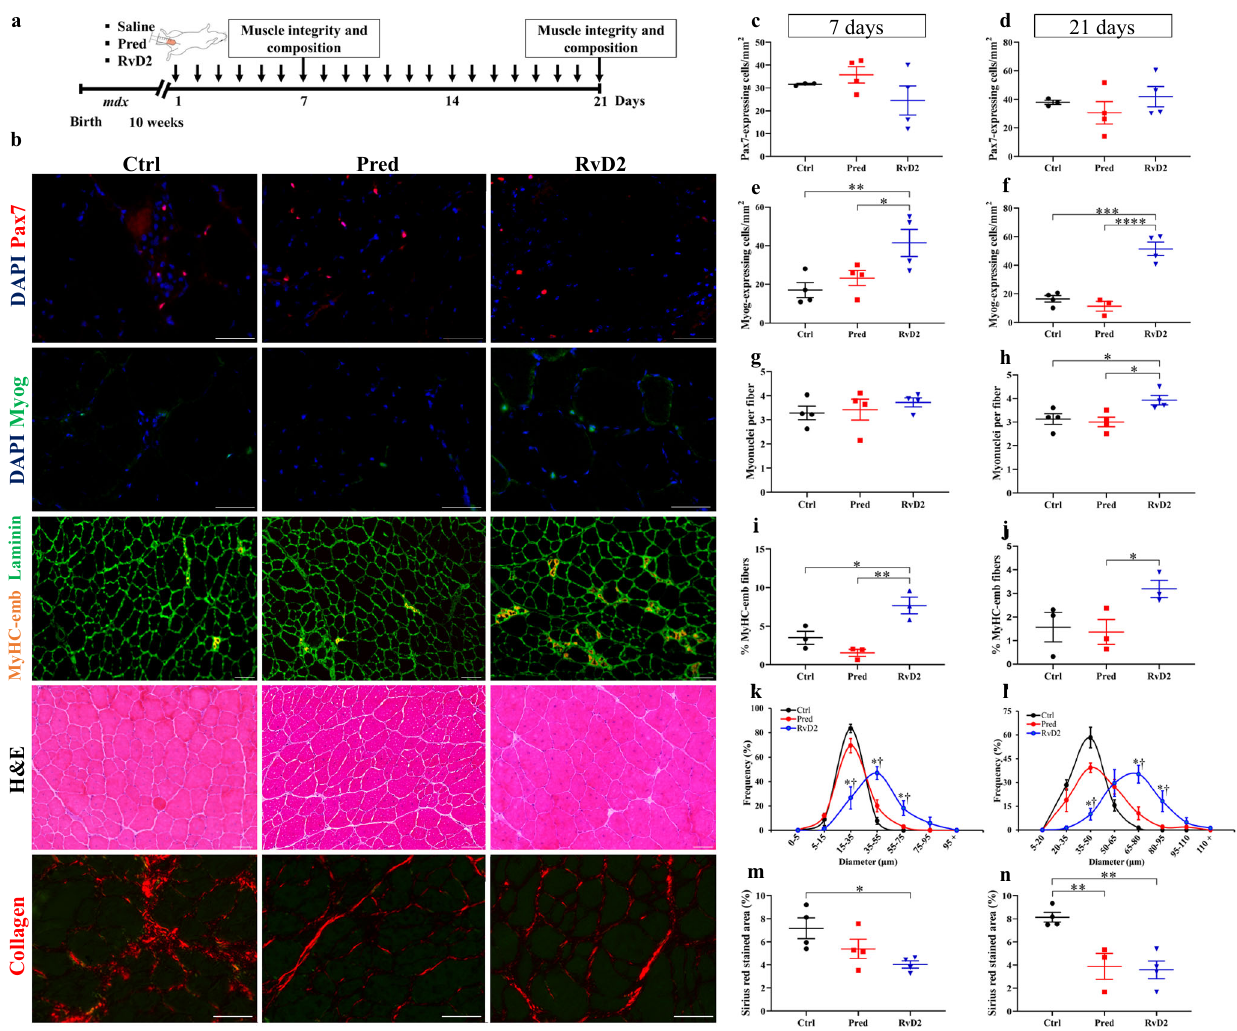
Fig. 5 Resolvin-D2 promotes myogenesis to a higher level than glucocorticoids in dystrophic mdx mice. a Timeline of daily intraperitoneal ( ip ) injection of Resolvin-D2 (RvD2, 5 ug/kg/day), prednisone (pred, 2 mg/kg/day), or vehicle (ctrl) in mdx mice. b Representative images of Pax7 (red), Myog (green), embryonic Myosin Heavy Chain (MyHC-emb; orange) + laminin (green), H&E on muscle sections of tibialis anterior (TA) muscle and collagen (Sirius red; red) on diaphragm sections of mdx mice treated with RvD2, pred, or vehicle. Scale bars = 50 μ m. c – f Quanti fi cation of number of Pax7 + ( c , d ) and Myog + cells ( e , f ) in TA muscles of mdx mice treated for 7 days ( e : Ctrl vs. Pred, p = 0.4138; Ctrl vs. RvD2, p = 0.0084; Pred vs. RvD2, p = 0.0338) or 21 days ( f : Ctrl vs. Pred, p = 0.3720; Ctrl vs. RvD2, p = 0.0001; Pred vs. RvD2, p < 0.0001). g , h Number of myonuclei per fi ber after 7 or 21 days of treatment (21 d: Ctrl vs. Pred, p = 0.6880; Ctrl vs. RvD2, p = 0.0263; Pred vs. RvD2, p = 0.0134). i , j Proportion of myo fi bers expressing embryonic Myosin heavy chain (MyHC-emb) after 7 (Ctrl vs. Pred, p = 0.1513; Ctrl vs. RvD2, p = 0.0124; Pred vs. RvD2, p = 0.0021) or 21 days of treatment (Ctrl vs. Pred, p = 0.7919; Ctrl vs. RvD2, p = 0.0681; Pred vs. RvD2, p = 0.0467). k , l Distribution curve of minimal fi ber diameter in TA muscles of mdx mice treated for 7 days (15 – 35 μ m: Ctrl or Pred vs. RvD2, p < 0.0001. 35 – 55 μ m: Ctrl vs. RvD2, p < 0.0001; Pred vs. RvD2, p = 0.0001. 55 – 75 μ m: Ctrl vs. RvD2, p = 0.0058; Pred vs. RvD2, p = 0.0181) or 21 days (35 – 50 μ m: Ctrl or Pred vs. RvD2, p < 0.0001. 65 – 80 μ m: Ctrl or Pred vs. RvD2, p < 0.0001. 80 – 95 μ m: Ctrl vs. RvD2, p = 0.0035; Pred vs. RvD2, p = 0.0101). m , n Proportion of diaphragm muscle section stained with Sirius red (collagen) after 7 days (Ctrl vs. Pred, p = 0.1176; Ctrl vs. RvD2, p = 0.0141; Pred vs. RvD2, p = 0.2234) or 21 days of treatment (Ctrl vs. Pred, p = 0.0050; Ctrl vs. RvD2, p = 0.0022; Pred vs. RvD2, p = 0.7956). c – n RvD2 = blue triangles, pred = red squares, and Ctrl = black circles. Data are presented as mean ± SEM, n = 4 mice per group/time-point (except n = 3 for i , j , k , and l ; Ctrl group for c and d ; Pred group for f and n ). Experiments were performed in technical duplicates using one-way ANOVA uncorrected Fisher ’ s LSD test (two-way ANOVA for k and l ). All data were analyzed with a 95% con fi dence interval. * p < 0.05; ** p < 0.01; *** p < 0.001; **** p < 0.0001 for c – j , m , and n . * p < 0.05 compared with the vehicle; † p < 0.05 compared with prednisone for k and l